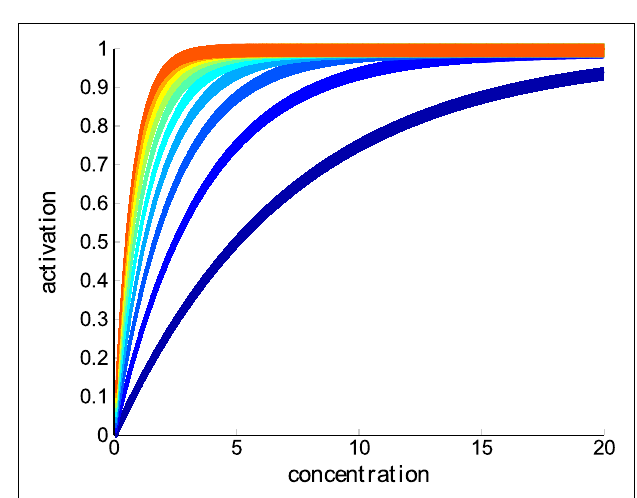
FIGURE 2 | Olfactory receptor-odorant affinity matrix. In total, 384 ORs were generated with graded affinity to each of the 447 odorants. Shown is a subset of 60 ORs and the 30 odorants to which